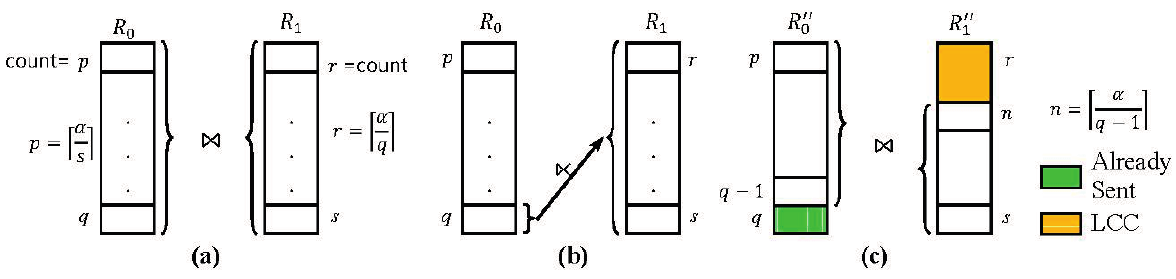
Figure 3. Low Count Cut with Highest Count First Strategy. ( a ) Logical fragmentation of and (cid:1844) , where (cid:1844) (cid:1844) = ⋃ (cid:2868) (cid:2869) (cid:2868)